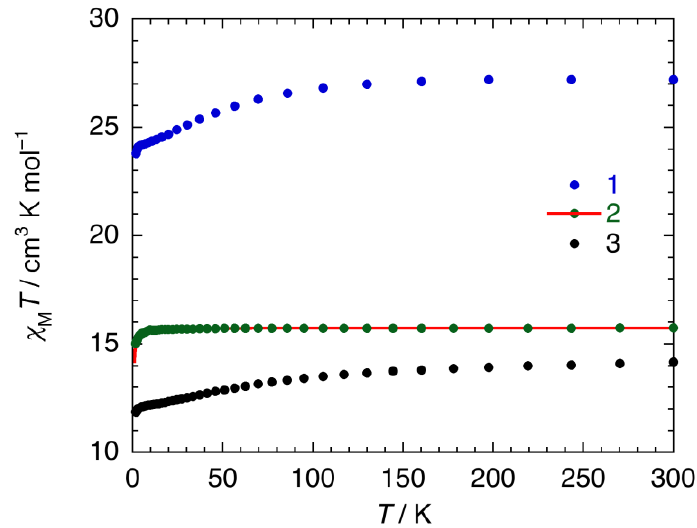
Figure 4. T dependence of χ M T products for 1 – 3 . The solid red line represents fit to the data, which is described in the text.